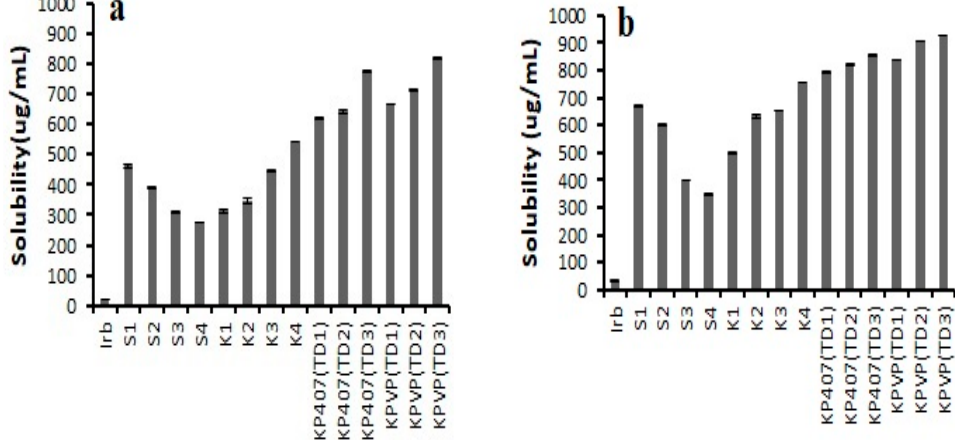
Figure 3. Saturation solubility data of pure Irbesartan and solid dispersions in ( a ) pH 6.8 phosphate ± buffer, ( b ) 0.1 N HCl (pH 1.2) (n = 3, mean ± SD). buffer, ( b ) 0.1 N HCl (pH 1.2) (n = 3, mean